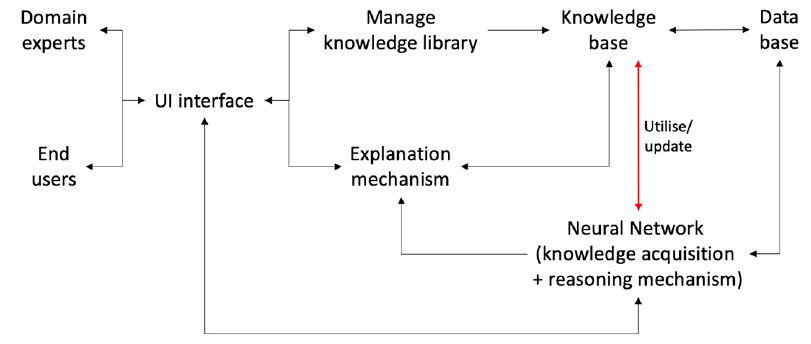
Figure 8. Expert System based on BP Neural Network [76].